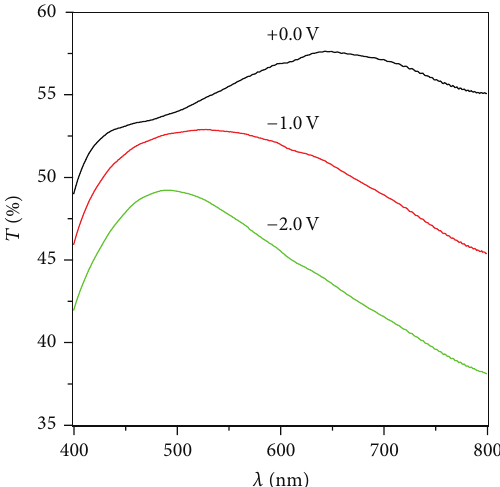
Figure 8: UV-VIS transmittance spectra of a complete cell contain- ing V 2 O 5 and WO 3 films registered at 0, − 1, and − 2V versus V 2 O 5